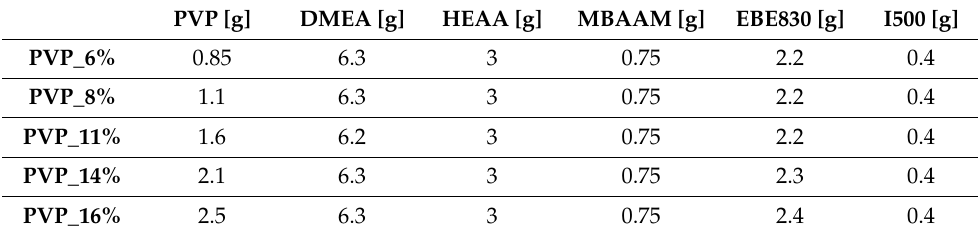
Table 2. Ratios of compounds used in the individual